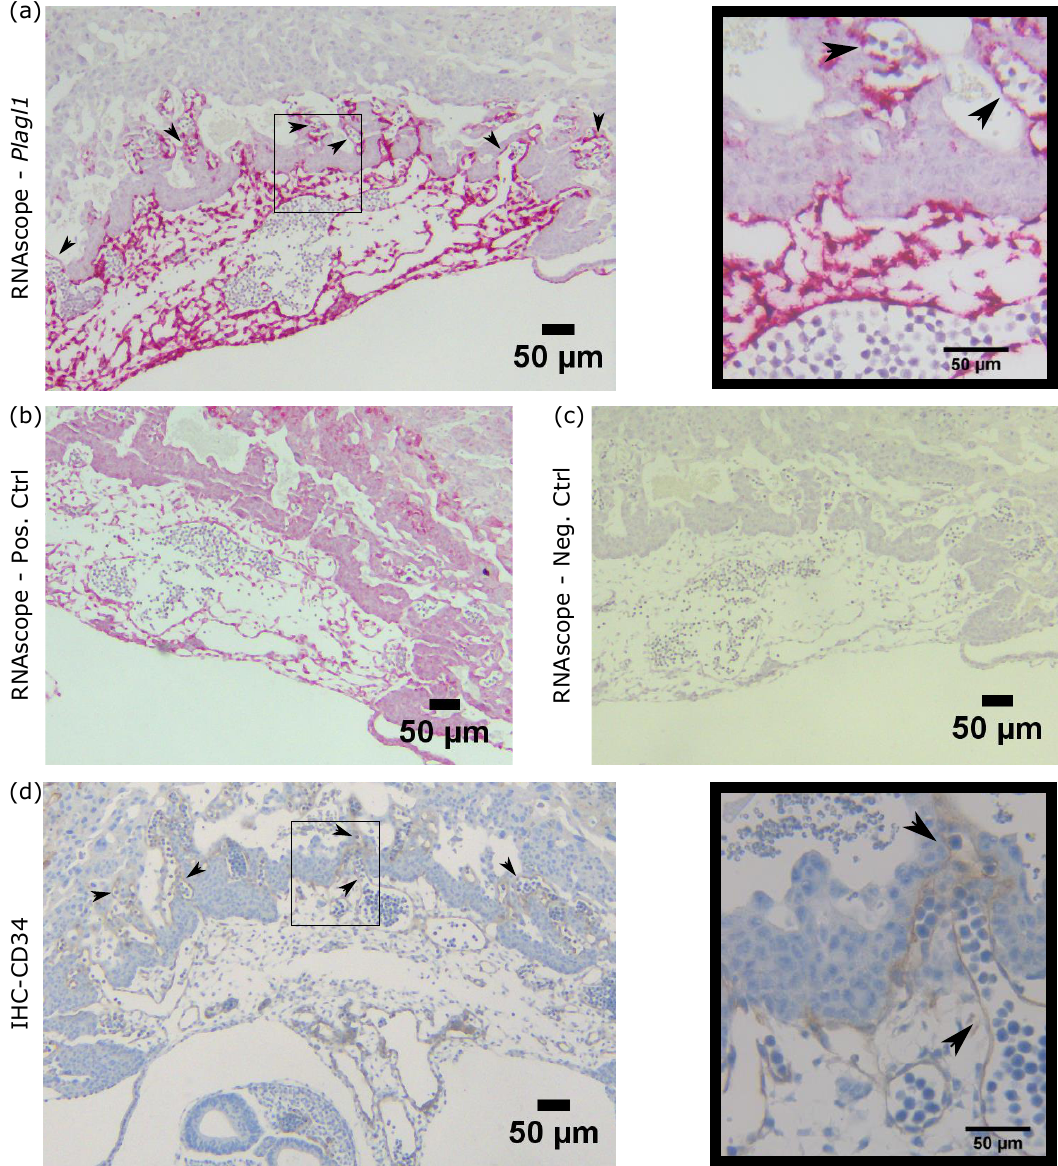
Figure 3. Plagl1 is expressed within the developing labyrinth layer and allantois of the e9.5 mouse placenta. ( a ) RNAscope shows Plagl1 RNA in the developing labyrinth as well as throughout the allantois (dark red) in the e9.5 placenta. Box shows zoomed in region (right). Arrowheads indicate Plagl1 staining of endothelial cells forming fetal blood vessels. ( b ) RNAscope positive control staining PPIB within the placenta to determine RNA viability. ( c ) RNAscope negative control staining DapB within the placenta to determine nonspecific staining. ( d ) Immunohistochemistry shows CD34 staining of the vascular endothelial cells, displaying a similar pattern to Plagl1 within the developing labyrinth. Box shows zoomed in region (right). Arrowheads indicate CD34 staining.